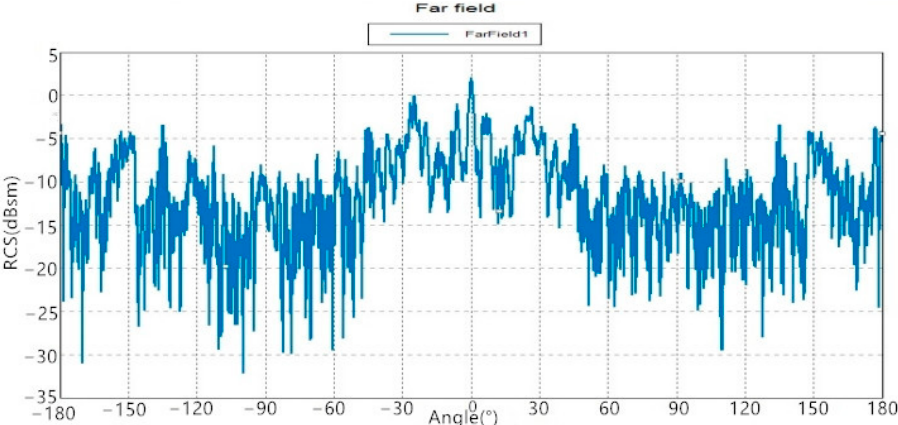
Figure 8. Radar cross-section distribution characteristics of the corner reflector and Luneburg ball array.